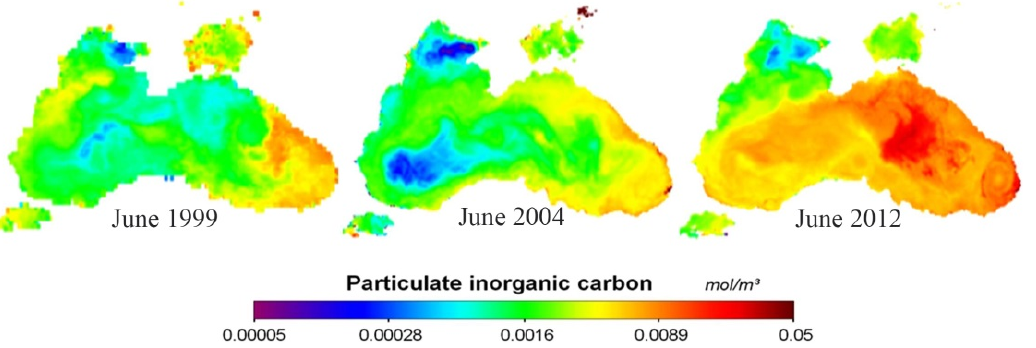
Figure 8. Distribution of coccolithophores (PIC) in 1999, 2004, 2012 blooming periods according to the MODIS-Aqua (June averages).